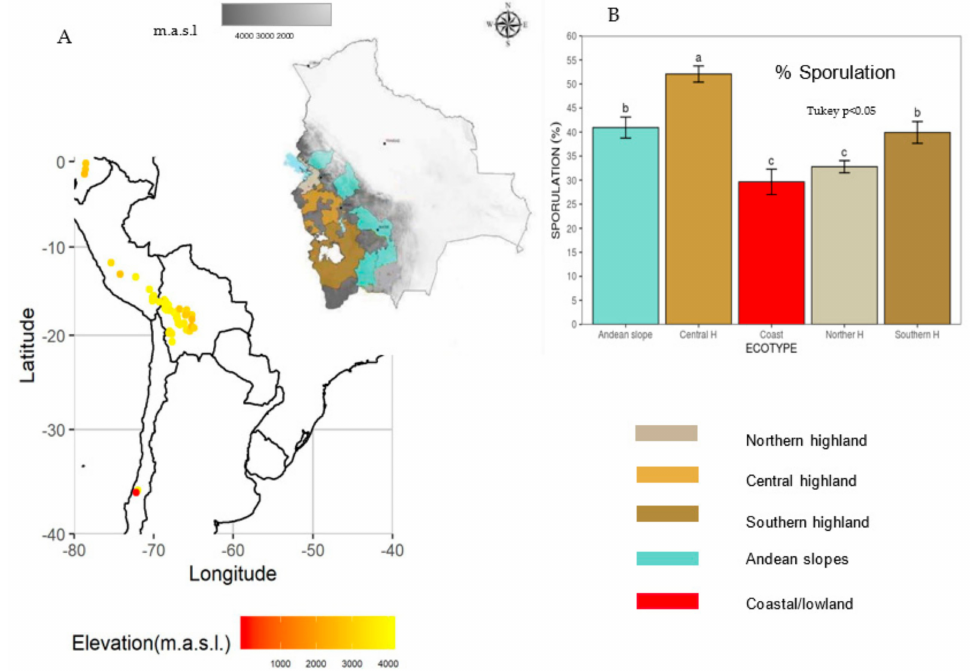
Figure 12. ( A ) Modified map of germplasm bank accession across South America by elevation Source: Colque-Little et al. (2021) [52] and modified map of Bolivian ecoregions for quinoa production. Source: Gandarillas et al. (2015) [6]. ( B ) Mean sporulation on diversity panel related to quinoa ecoregions calculated with Tukey test ( p = 0.05). Different letters (a,b,c) represent significant differences between the sporulation produced by genotypes coming from different ecoregions when infected with P. variabilis